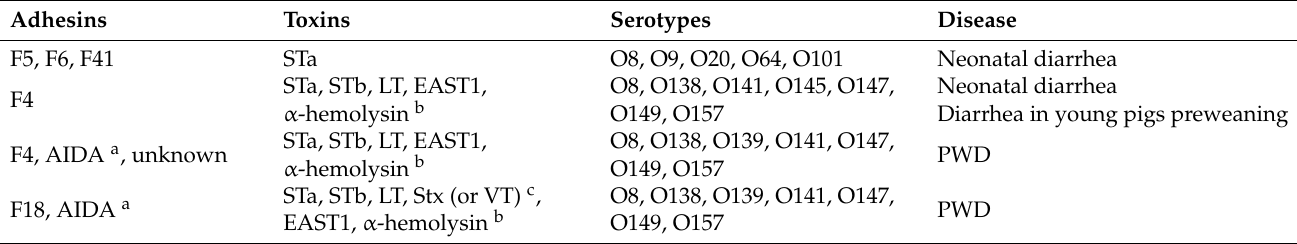
Table 1. Virulence factors of enterotoxigenic Escherichia coli (ETEC) associated with swine en- teric